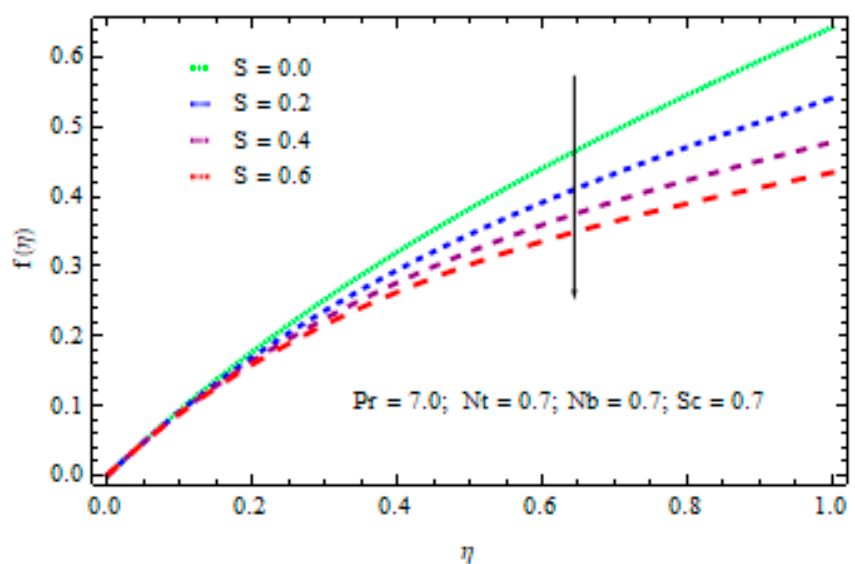
Figure 9. The impact of the unsteady parameter S on the axial velocity.